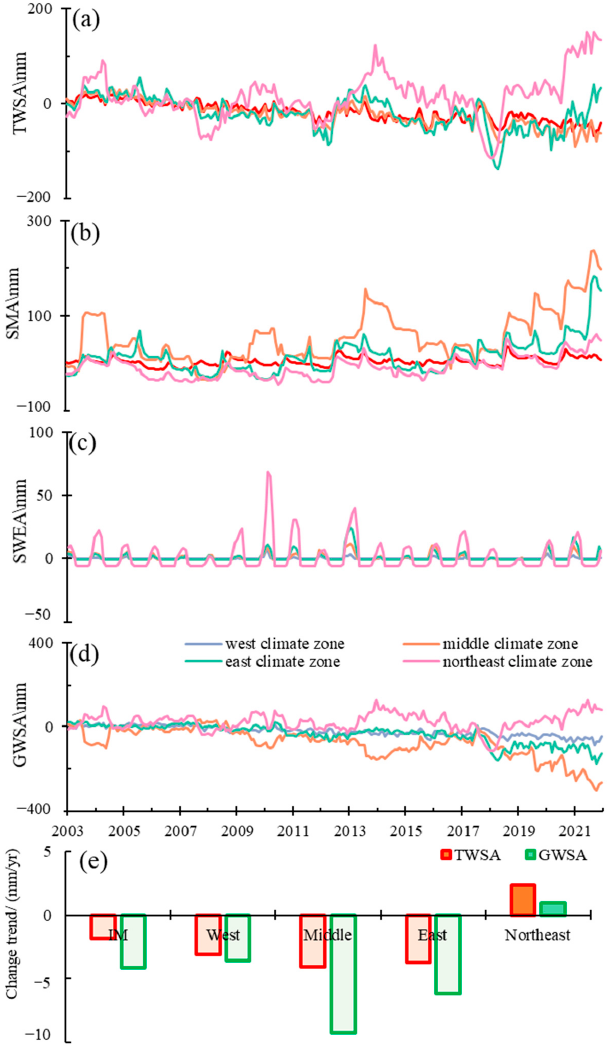
Figure 3. Temporal changes of TWSA and its components (SMA, SWEA and GWSA) in different cli- mate zones. (( a ) TWSA from CSR-M, ( b ) SMA from GLDAS_NOAH, ( c ) SWEA from GLDAS_NOAH, CLSM, and VIC, ( d ) GWSA based on water balance theory, ( e ) change trends of TWSA and GWSA in different climate zones (IM: Inner Mongolia; West: West climate zone; Middle: Middle climate zone; East: East climate zone; Northeast: Northeast climate